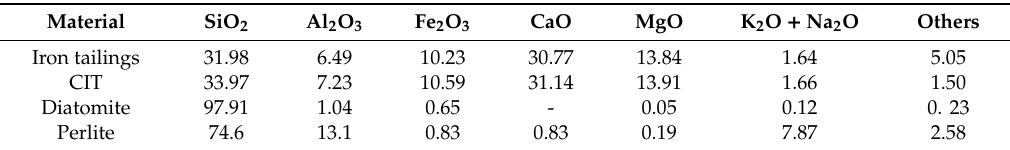
Table 1. Comparison of chemical constituent of iron tailings, calcination iron tailings (CIT), and some typical natural minerals [45,46].